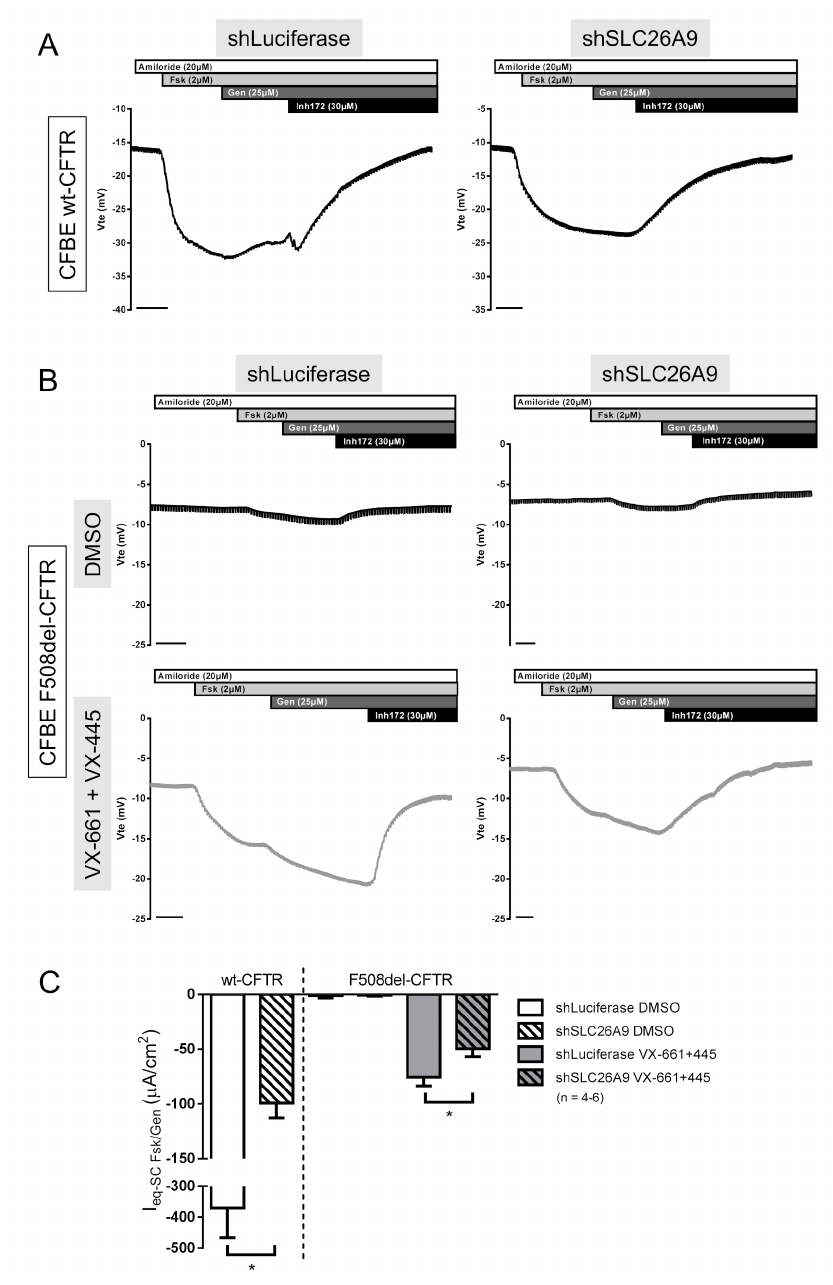
Figure 3. SLC26A9 knockdown inhibits wt-CFTR function and the correction of F508del-CFTR by VX-661 + VX-445. ( A ) Original Ussing chamber tracings obtained for CFBE wt-CFTR cells transduced with the control shRNA shLuciferase (left) or shSLC26A9 (right). CFTR was activated by 2 µ M Forskolin (Fsk) and 25 µ M Genistein (Gen) in the presence of the epithelial sodium channel (ENaC) inhibitor (Amiloride, 20 µ M) and was inhibited by CFTR-inhibitor 172 (Inh172, 30 µ M). All compounds were added to the luminal side. ( B ) Original Ussing chamber tracings obtained for cAMP-induced Cl − currents activated and inhibited as in ( A ) in the absence (top tracings, black) or in the presence (lower tracings, grey) of 5 µ M VX-661 + 2 µ M VX-445 for CFBE F508del-CFTR cells transfected with shLuciferase (left) or shSLC26A9 (right); ( C ) Summary of I sc-eq currents of CFBE wt-/F508del-CFTR stably transduced with shLuciferase vs. shSLC26A9 and treated with DMSO vs. VX661 + VX-445. Data are represented by mean ± SEM and “*” indicates statistically significant differences (unpaired t -test, p ≤ 0.05). The number of filters ( n ) used in the statistical analyses is indicated in the graph. Scale bars in ( A , B ) represent 1